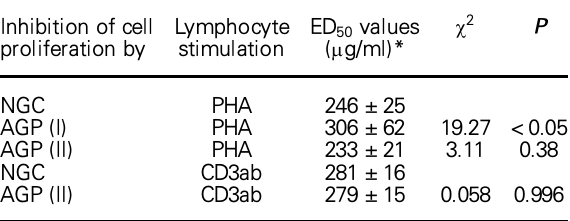
Table 1. Comparison of antiproliferative effects of two AGP lots with a neoglycoconjugate